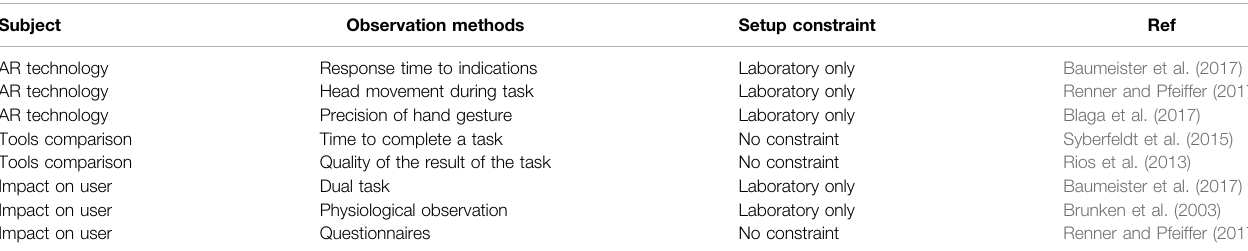
TABLE 1 | Available criteria and observation methods for evaluation of